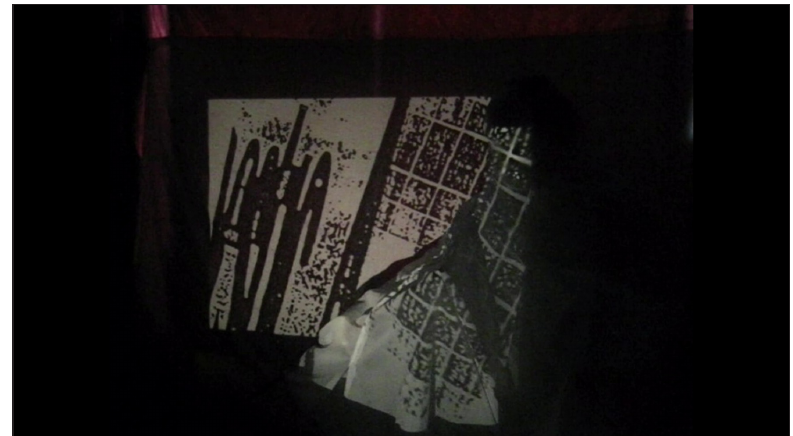
Figure 4.2: (2.49) Jennifer Pike with Veryan Weston, 2007. Courtesy of Veryan Weston.